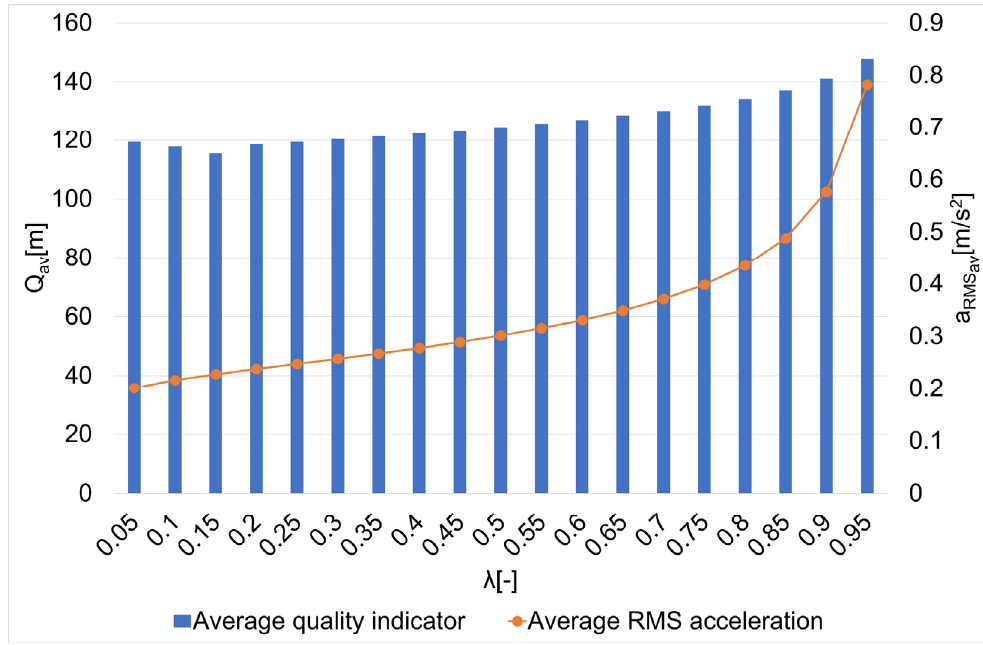
Figure 12. The values of the average quality indicator Q and the average mean square value of acceleration a RMS for the smoothing parameters in the case of paths no. 1–7 [6]. The Q av indicator obtained the minimum value for the smoothing parameter λ = 0.15